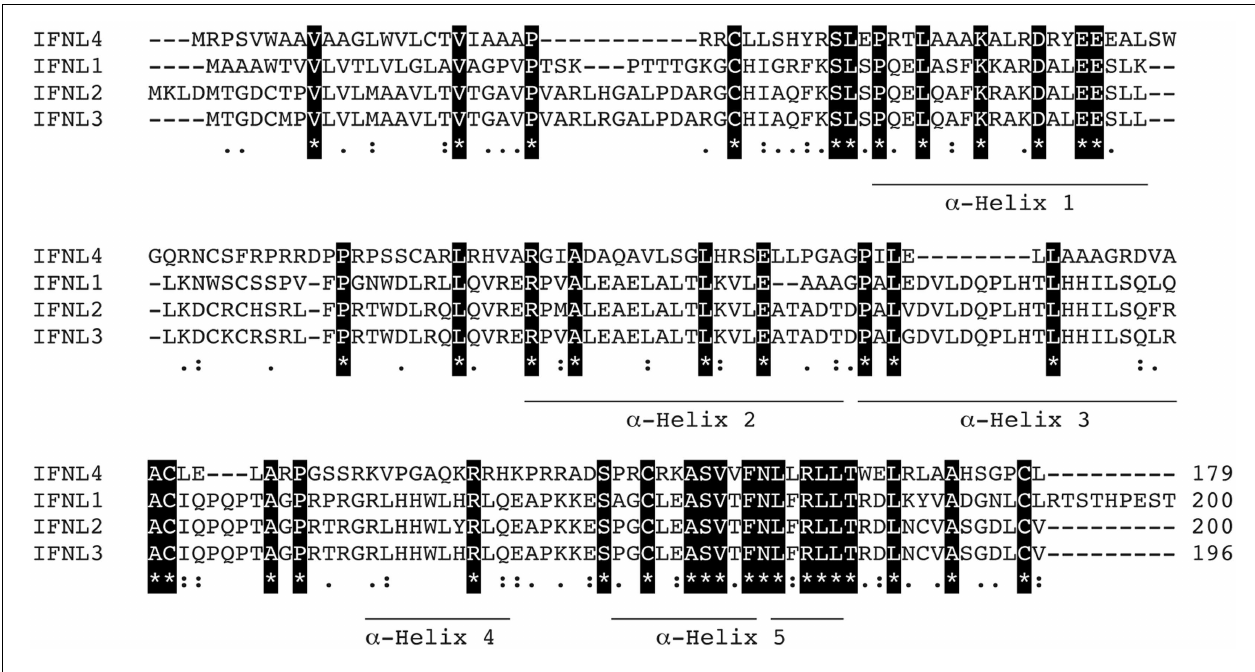
black, conserved amino-acids are represented by a colon (:) and semi-conserved amino-acids by a period (.). Alpha helices are indicated and are based on the crystal structure of IFNL3 (3HHC chain A) (73–75).